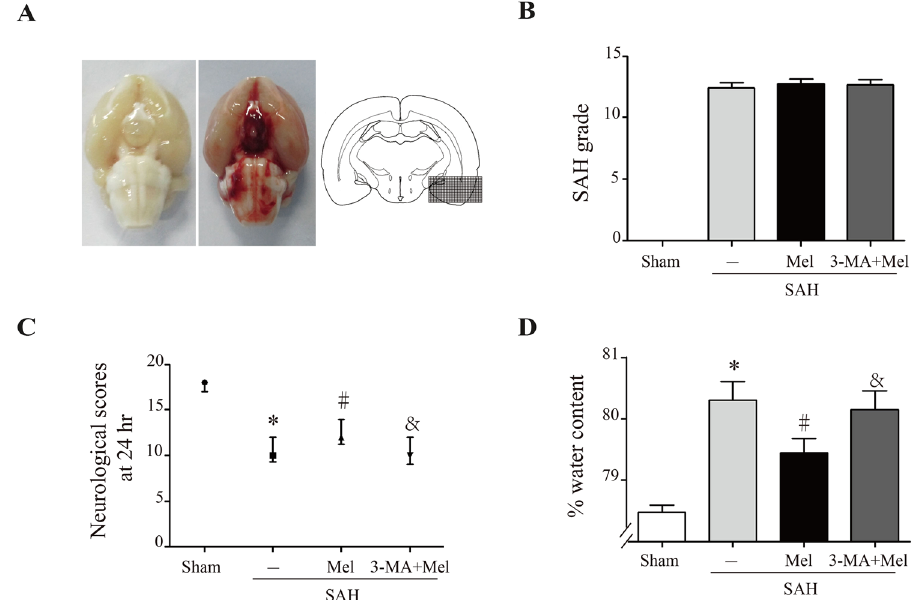
Figure 1. Effect of melatonin treatment on brain injury 24 h after SAH induction. ( A ) Representative brains from the sham and SAH groups, and the optimal region of brain section for immunochemistry. ( B ) The quantification of SAH severity, n = 24 per group. ( C ) The quantification of neurological scores. Values are presented as medians (interquartile range); n = 24 per group. ( D ) Brain water content measured by the wet-dry method; n = 6 per group. * P < 0.05 versus sham group, # P < 0.05 versus SAH + vehicle group, and & P < 0.05 versus SAH + Mel